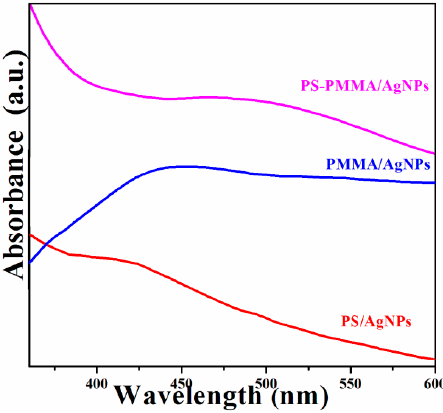
Figure 4. UV spectra of polymer/AgNPs nanocomposites.